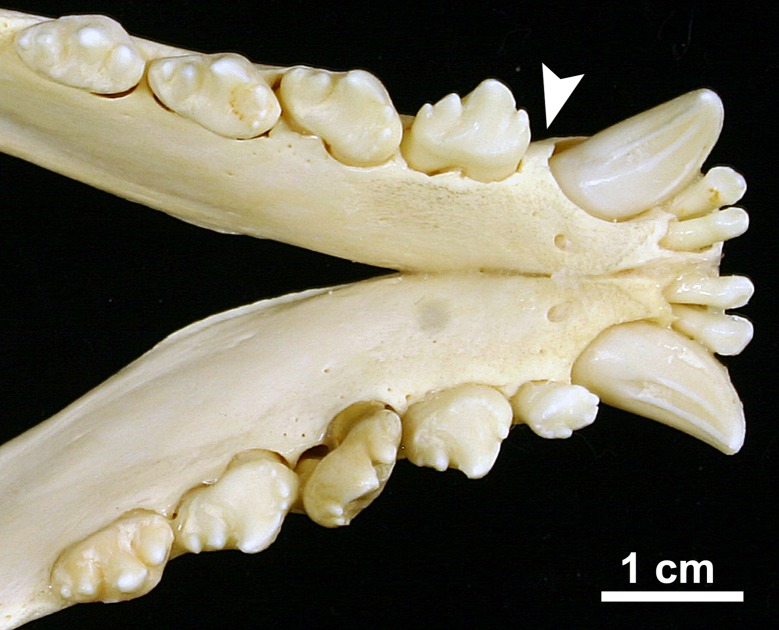
Example of congenital tooth absence in an Eastern Atlantic harbor seal (Phoca vitulina vitulina).Dorsal view of the mandibles of a 1-year-old male (specimen ZIK 24885). The left P1 is missing, there is no indication of an alveolus (arrowhead), and the distance between canine and P2 is shorter on the left than on the right side.